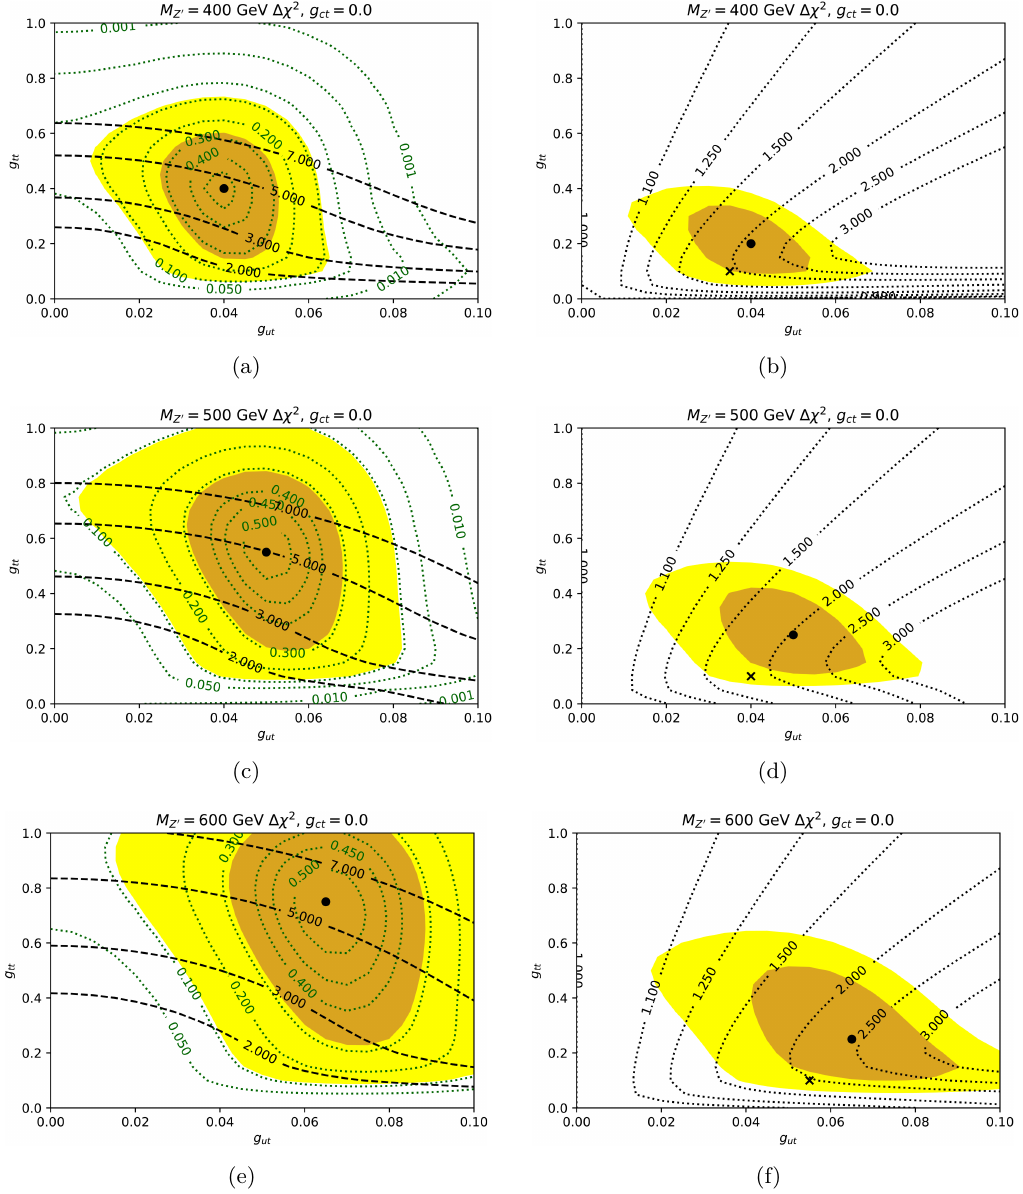
Figure 4 . Idem as in figure 3, but for M Z 0 > 2 m t . In this case, the opening of the decay Z 0 → t ¯ t enhances the channel ug → tZ 0 → t ¯ tt which induces a charge imbalance that favours considerably the fit in t ¯ tH . This can be appreciated in the goodness-of-fit (green dotted), which is considerably better in this case than for those in figure